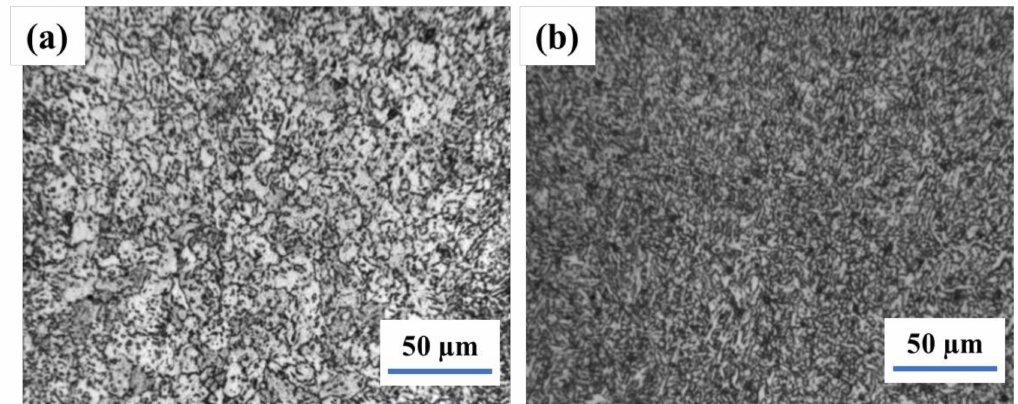
Figure 5. The Microstructure of weld joint after tempering at 660 ◦ C followed by intercritical normalizing − weld ( a ) and HAZ ( b